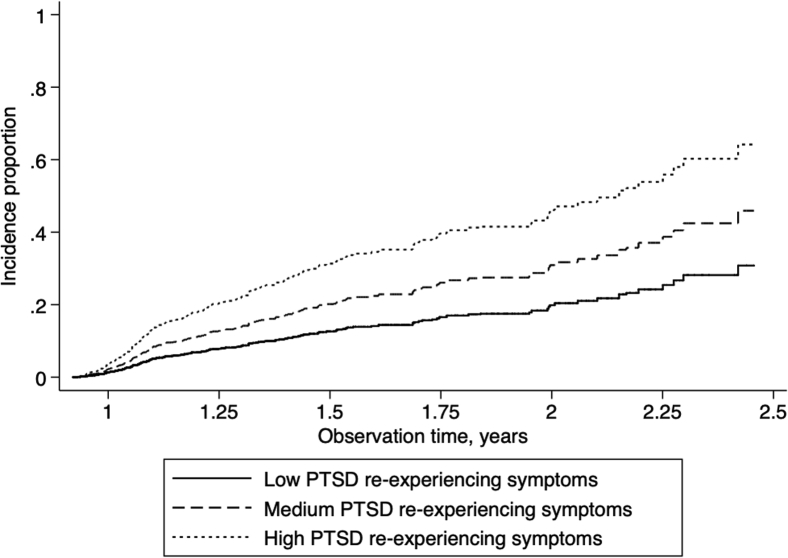
Incidence proportion of mild cognitive impairment over time among responders, separated by PTSD symptom severity groups. PTSD symptom severity was categorized into low (0–0.249; 78.0% of the sample), medium (0.25–0.49; 15.5% of the sample), and high (0.50–1.00; 6.4% of the sample) in this figure. Abbreviation: PTSD, posttraumatic stress disorder.